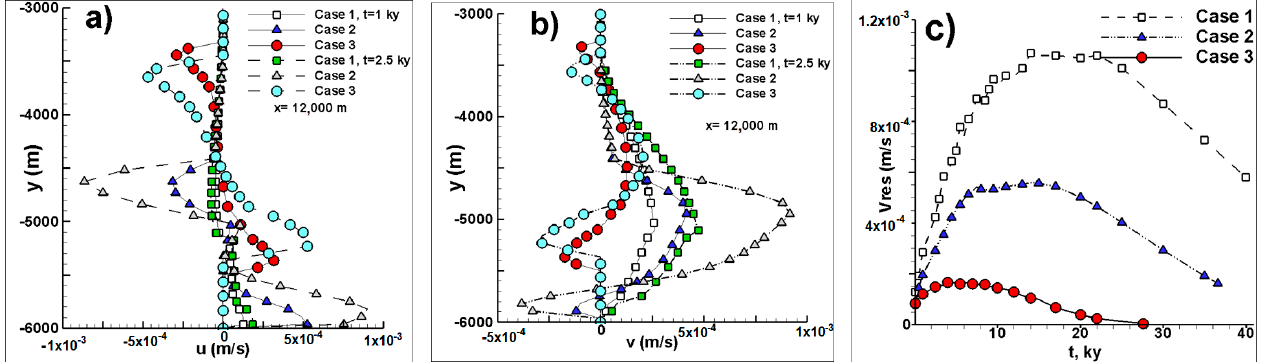
Figure 7. Velocity profiles for the three cases studied at x = 12,000 m (at the center of the computational domain) for ( a ) u and ( b ) v at two different times and ( c ) the resultant velocity average inside the whole chamber.